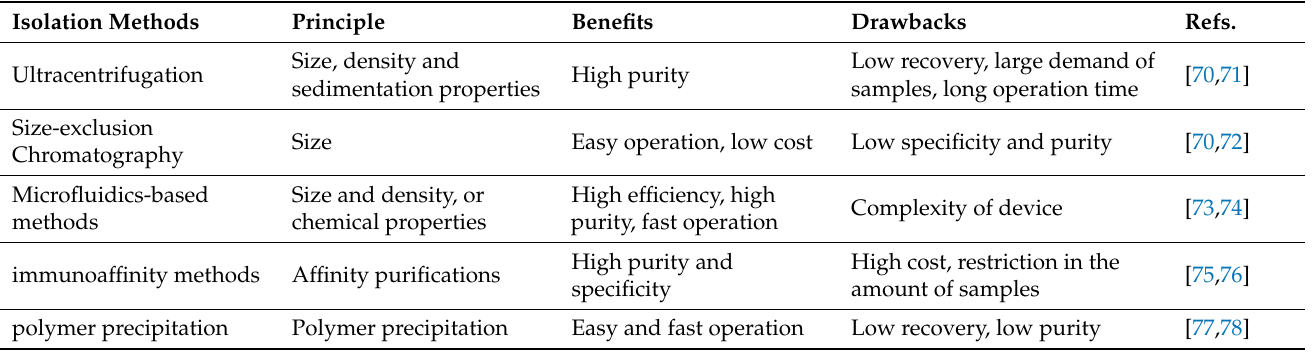
Table 1. Methods of isolating